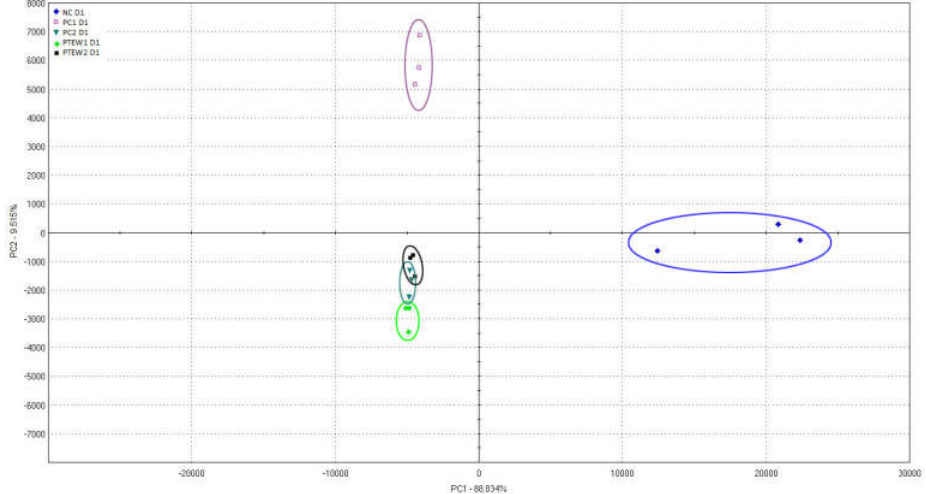
1 SE—standard error; 2 NC—negative control (liver p â t é s without a nitrite source); PC1—positive control (liver p â t é s with 60 ppm of sodium nitrite); PTEW1—liver p â t é s with plasma-treated egg white containing 40 ppm NO 2 − ; PC2—positive control (liver p â t é s with 120 ppm of sodium nitrite); PTEW2—liver p â t é s with plasma-treated egg white containing 80 ppm NO 2 − .